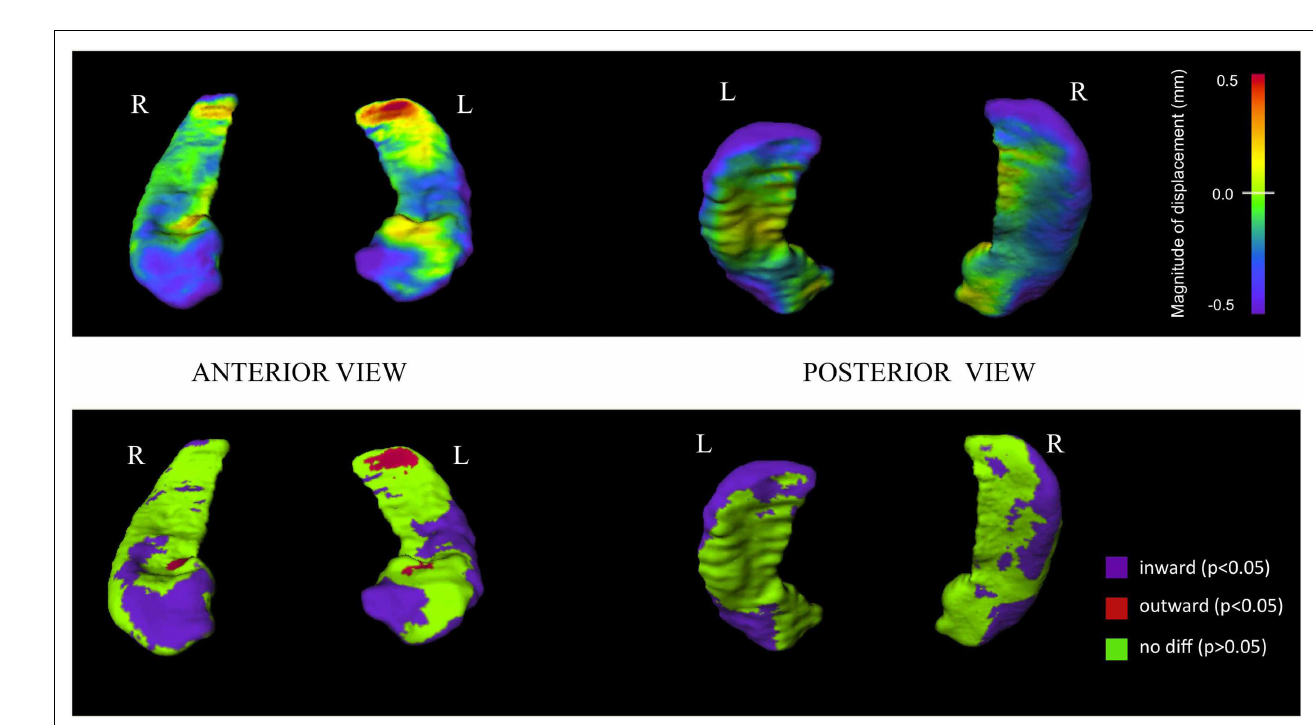
FIGURE 1 | Hippocampal surface maps showing baseline structural differences between first-episode psychosis patients and controls. Hippocampal surface generation of baseline scans was done by high-dimensional brain mapping (HDBM-LD) from a neuroanatomical template (see Materials and Methods). Groups were compared at each of 13,222 corresponding vertices on the hippocampal surface. Top row: structural differences are shown using a continuous color-coded scale. Purple/blue shading denotes regions of inward surface displacement (i.e., surface contraction) in first-episode psychosis patients compared to controls.